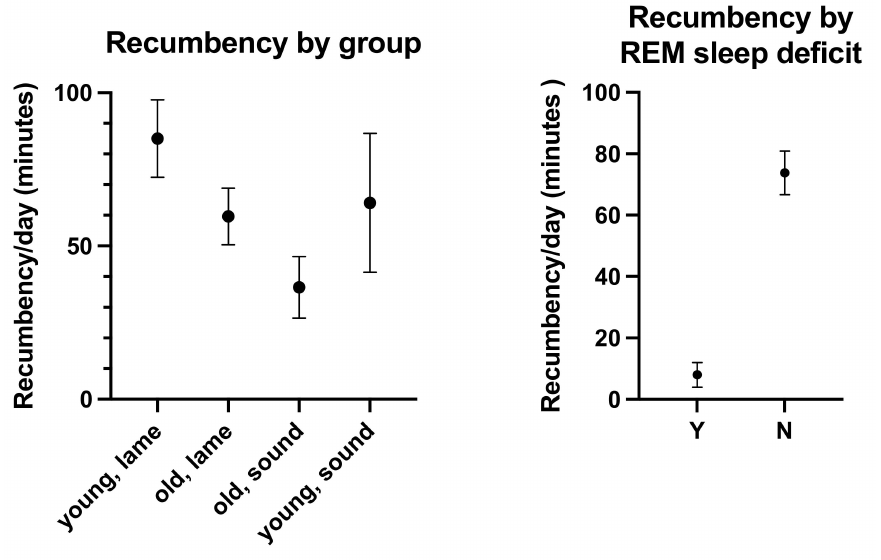
Figure 2. Comparative recumbency times (mean +/ − SEM minutes per day) of the horses enrolled in this study by age/lameness group and by the diagnosis of REM deficit (Yes (Y) and No